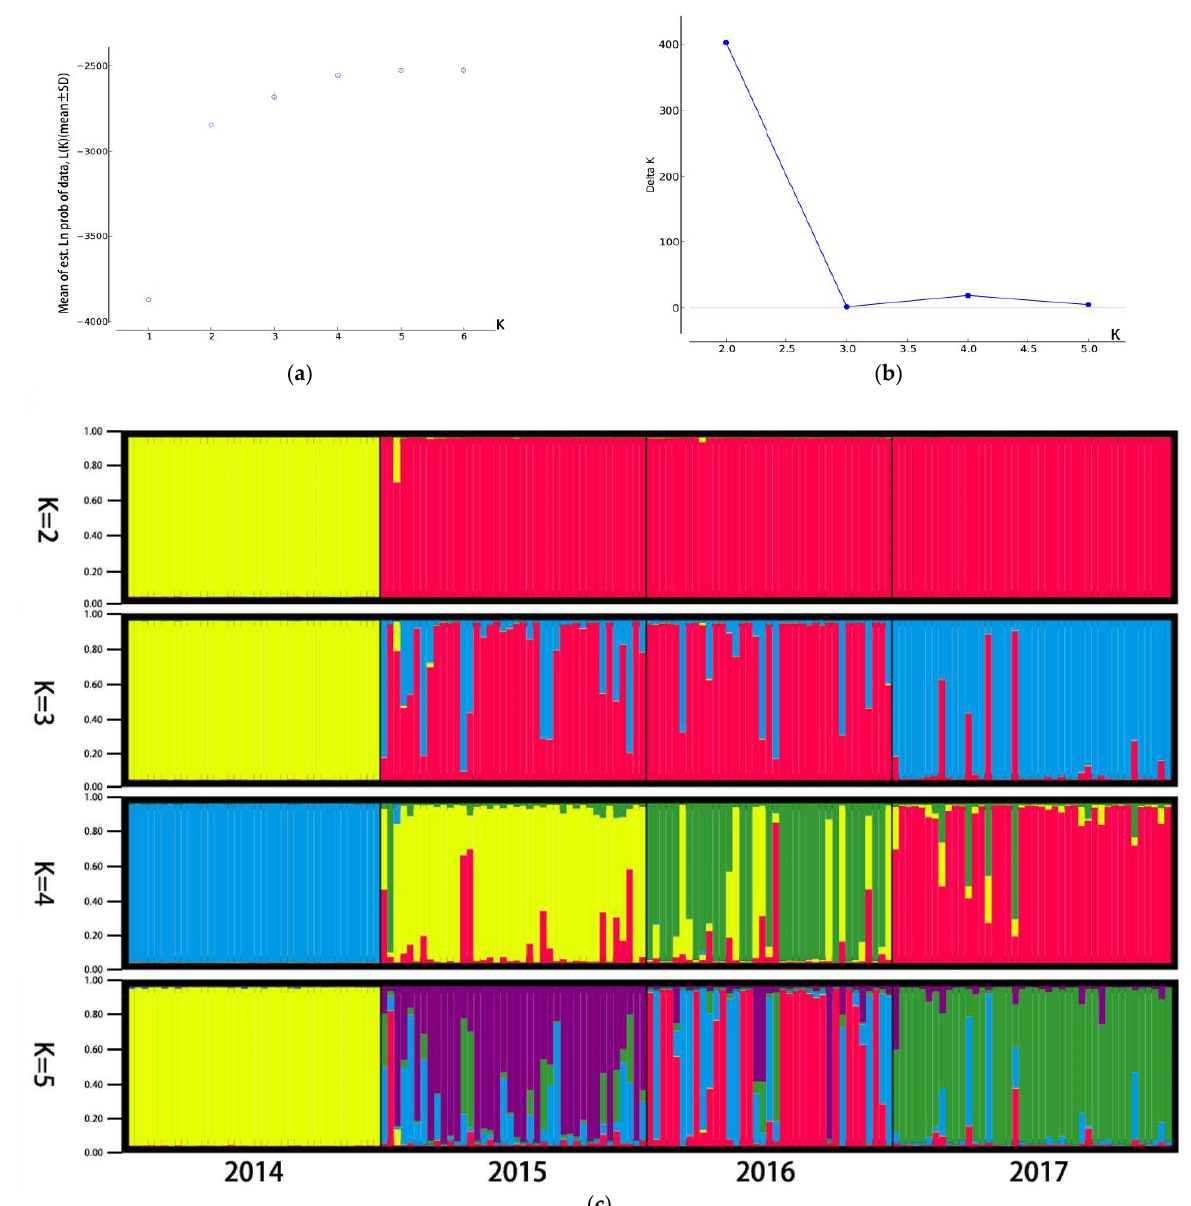
Figure 2. Population structure of four snail populations. ( a ) Mean ( ± SD) natural logarithm of the likelihood of the data [LnP(X|K)] for each value of assumed clusters (K). ( b ) Delta K values are plotted against the number of assumed K. ( c ) Genetic structure with the K value, respectively, taking 2, 3, 4 and 5. Each snail individual is represented by a thin vertical line, which is partitioned into K coloured segments that represents the individual’s estimated membership fractions in K clusters. The figure shown for a given K is based on the highest probability run at that K. Snail populations are labelled below the figure. Correspondence of colours across figures is not